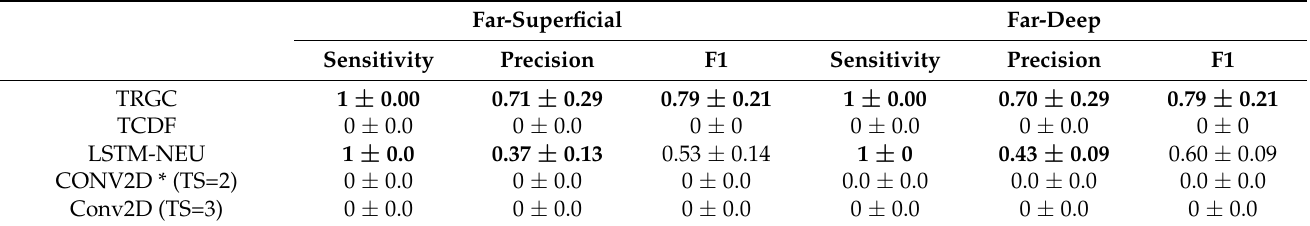
Table 2. Scores of the ANNs in comparison with TRGC, using Ground Truth 2. Results are based upon datasets where all 3 time series (TS) were included as predictors, with one exception: results from Conv2D with two time series as predictors, indicated with *, were also included. Far-Superficial Far-Deep Sensitivity Precision F1